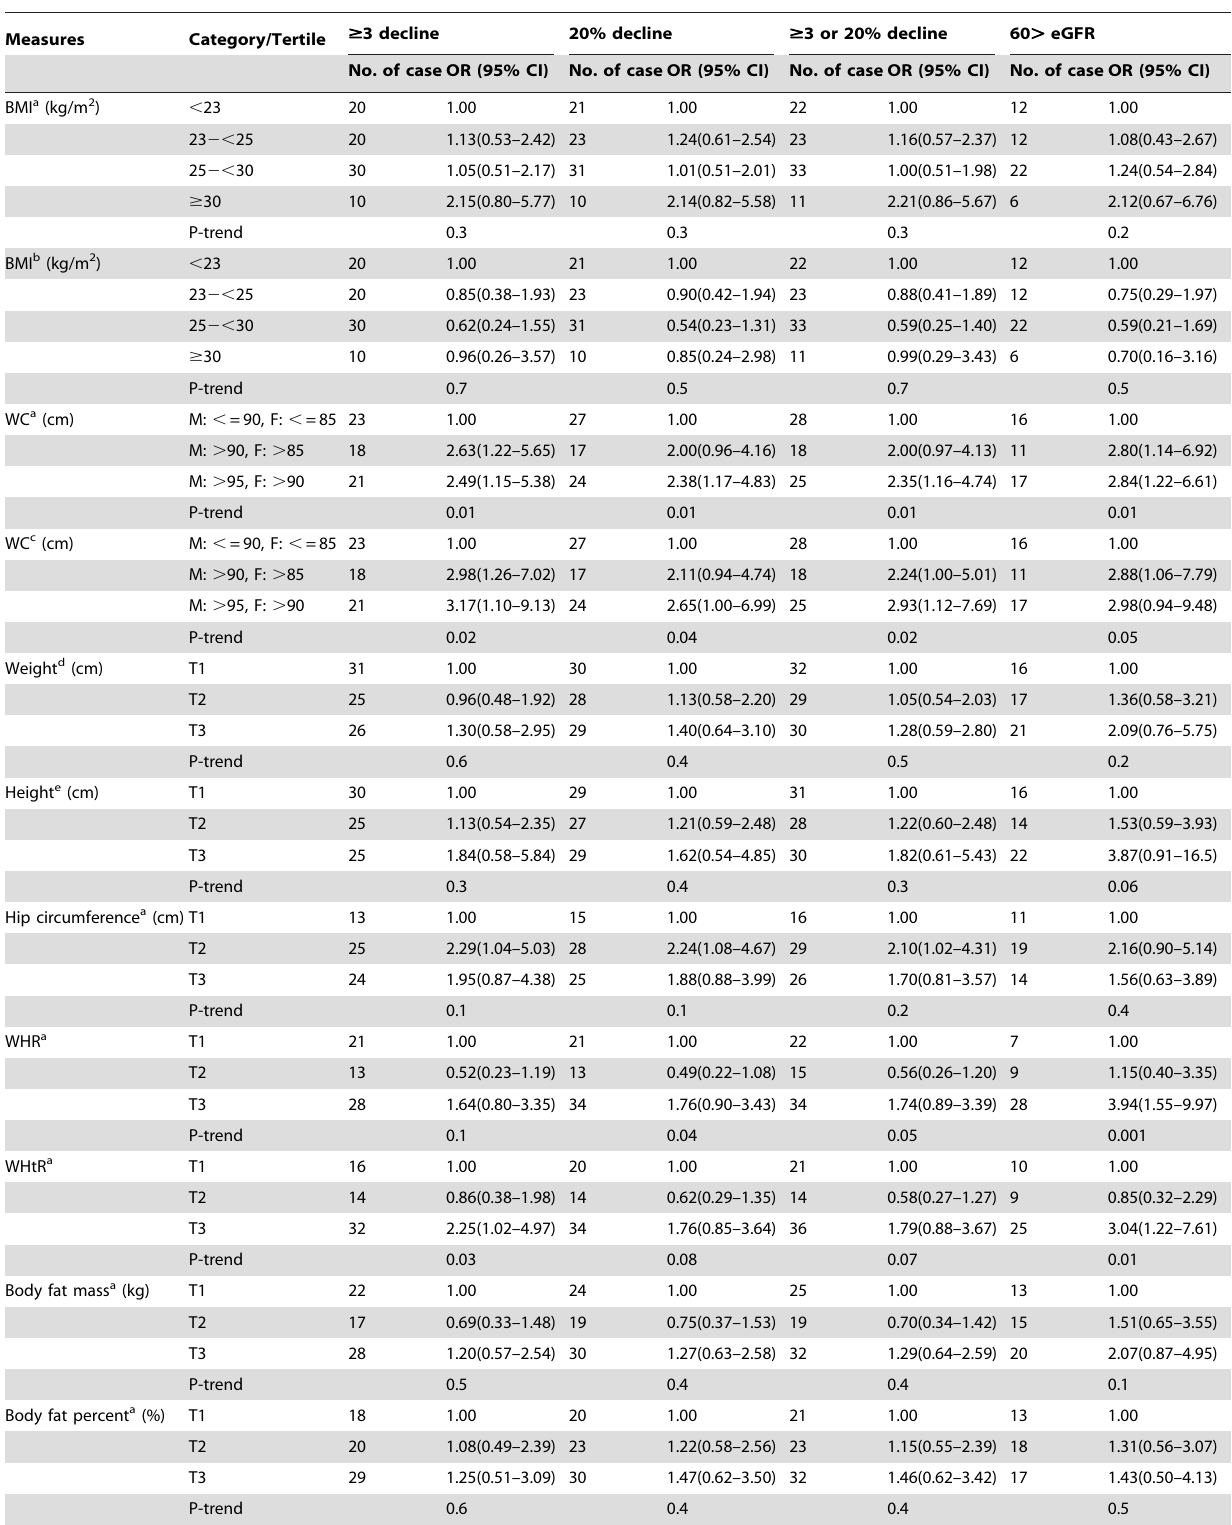
Table 3. Multivariate odds ratio (ORs) and 95% confidence intervals (CIs) of eGFR decline according to tertiles or categories of anthropometric